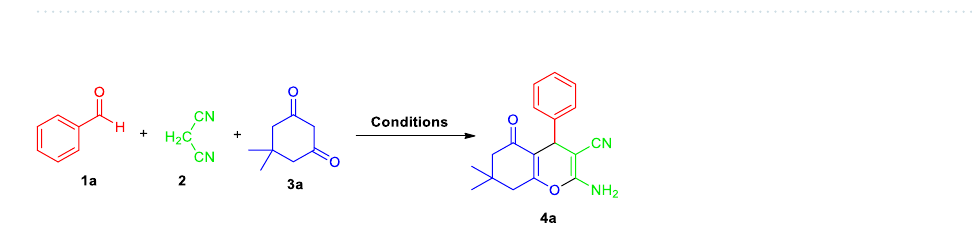
Figure 2. Liquid assisted grinding accelerated one-pot Brønsted acid-catalyzed domino multicomponent reactions for the synthesis of diverse complex-fused and spiro-heterocycles.